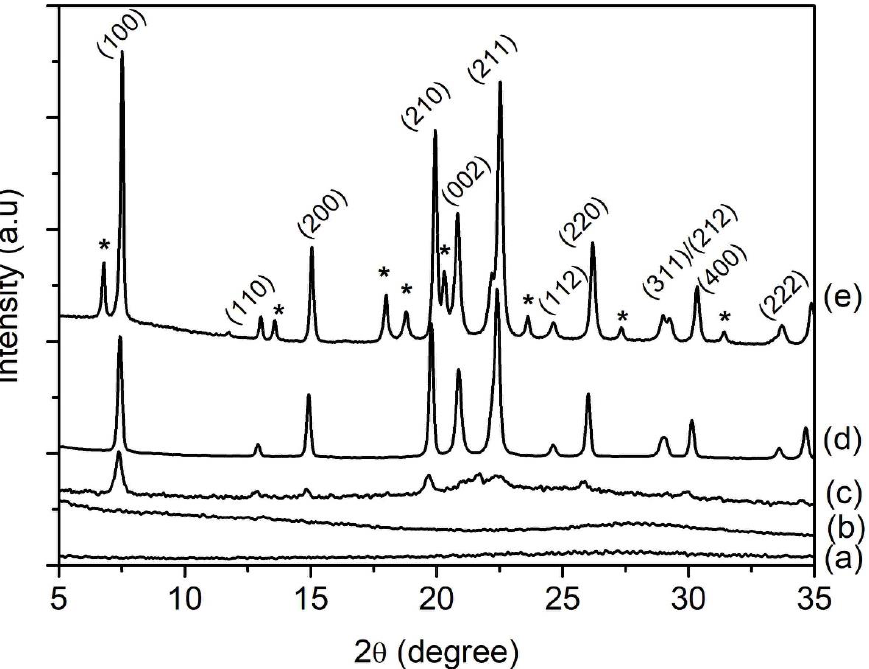
Figure 1. XRD patterns of ( a ) SH1, ( b ) SH2, ( c ) SH3, ( d ) SH4 and ( e ) SH5 samples prepared with a molar composition of 1Al 2 O 3 :2.5P 2 O 5 :0.47SiO 2 :2.5[bzmIm] 2 O:180H 2 O and heated at 150 °C for 2 h, 4 h, 8 h, 10 h and 14 h, respectively. Asterisks denote the presence of SAPO-41